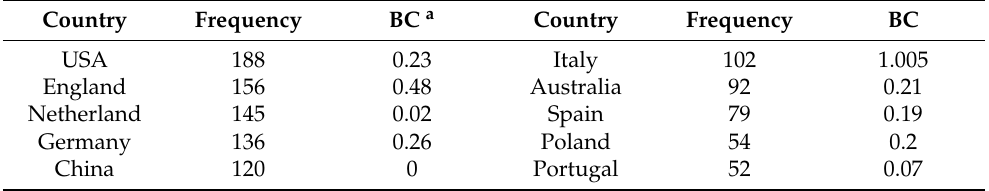
Table 2. Top ten countries with the highest number of papers published on spatial planning (WOSCC). Country Frequency BC a Country Frequency BC USA 188 0.23 Italy 102 1.005 England 156 0.48 Australia 92 0.21 Netherland 145 0.02 Spain 79 0.19 Germany 136 0.26 Poland 54 0.2 China 120 0 Portugal 52